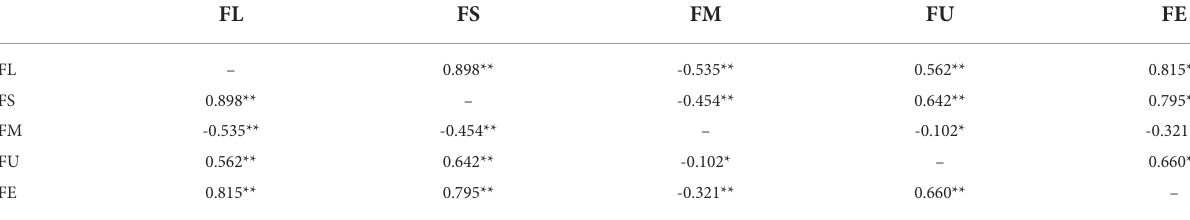
* and ** indicate signi fi cance at P = 0.05 and P = 0.01 levels,